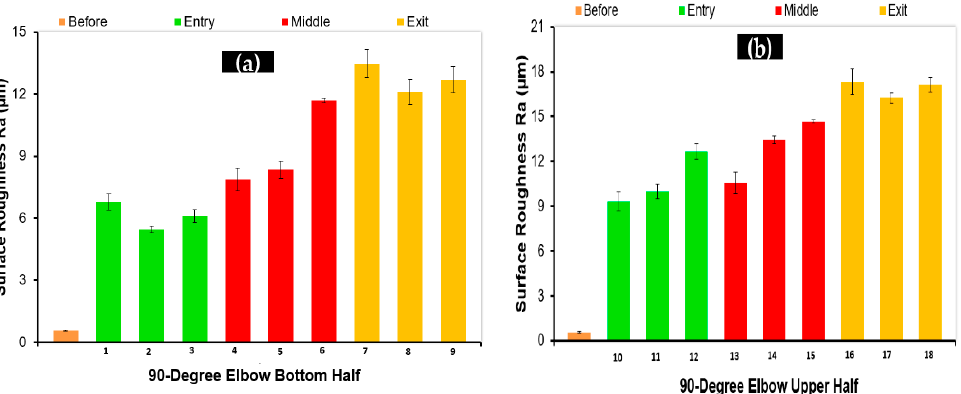
Figure 8. Arithmetic surface roughness values (Ra) before and after the test in 90° elbows: ( a ) bottom; ( b ) top.